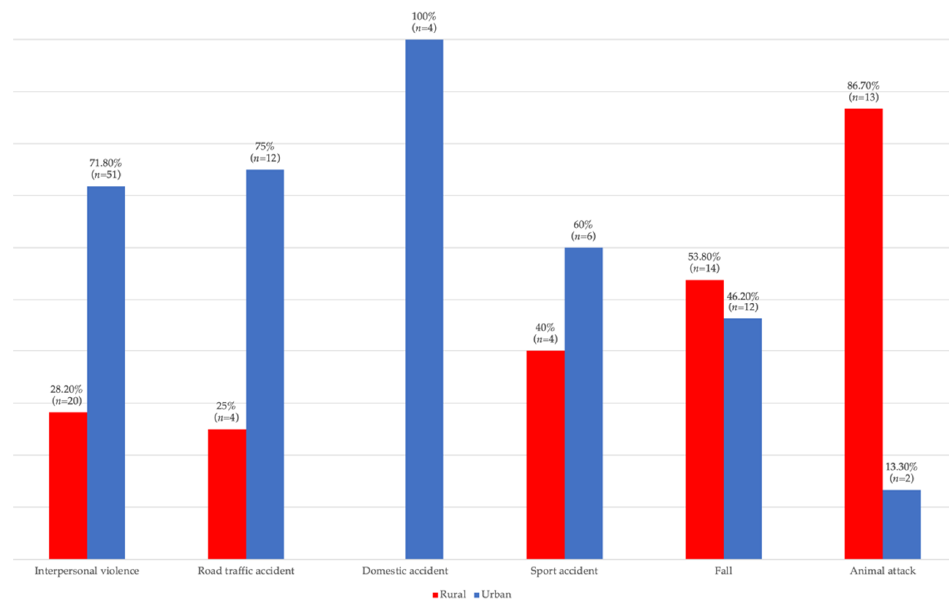
Figure 4. Distribution according to living environment and etiology.